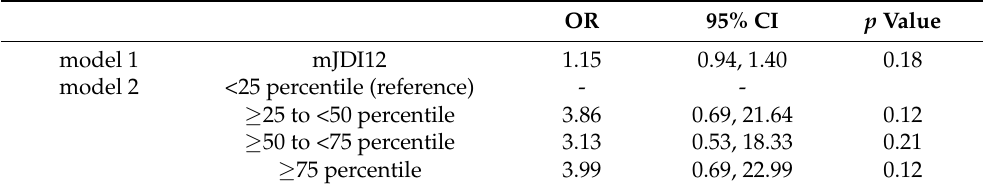
Table 6. Logistic regression analysis of mJDI12 for skeletal muscle mass at the 75th percentile or higher. OR 95%